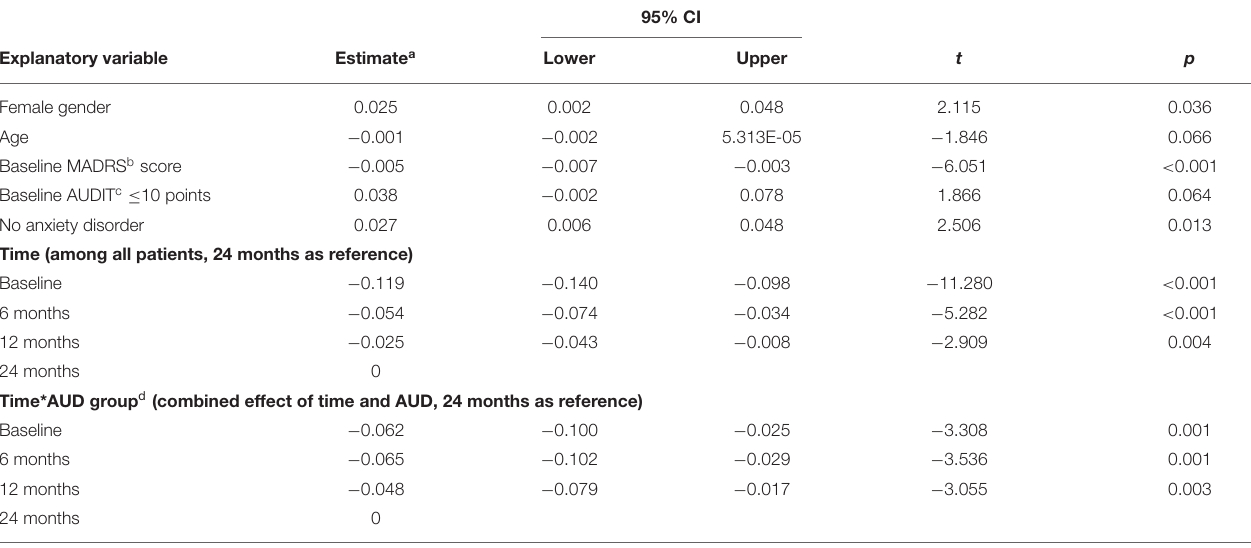
TABLE 3 | The results of linear mixed model for repeated measures of health-related quality of life of Ostrobothnian Depression Study patients measured by 15D instrument and including possible confounding factors.